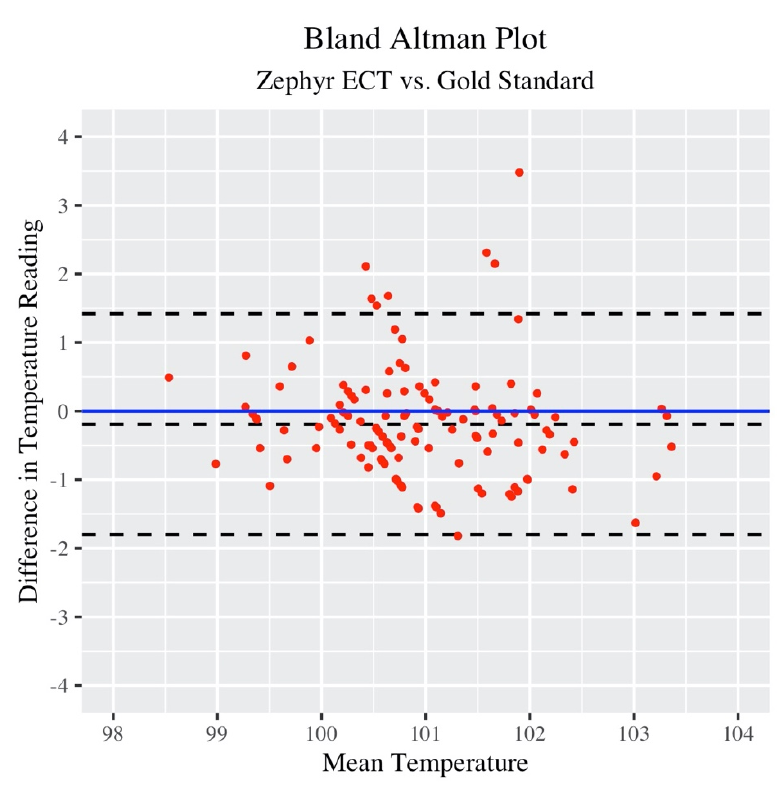
Figure 1. Bland–Altman plot: Zephyr estimated core temperature (ECT) versus Gold Standard.